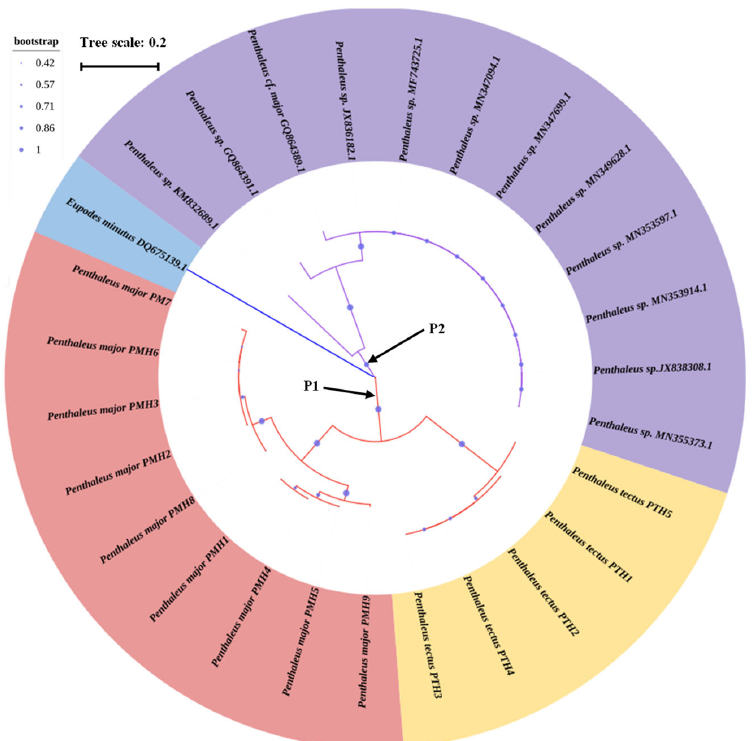
Figure 3. The Neighbor-Joining phylogenetic relationship of 9 haplotypes of P. major , 5 haplotypes of P. tectus , and 12 haplotypes of P . sp. The scale bar indicates the average number of nucleotide substitutions per site. The picture was first drawn in MEGA 7.0, and then the picture was adjusted through the online website (https://itol.embl.de/ accessed on 24 March 2023). The haplotypes of P. major and P. tectus populations are shown by the TCS network, with varying colors and sizes of circles representing different sampling sites and the number of individuals detected. MH3 is the most crucial haplotype for P. major , and TH1 is the most abundant haplotype for P. tectus (Figure 4).